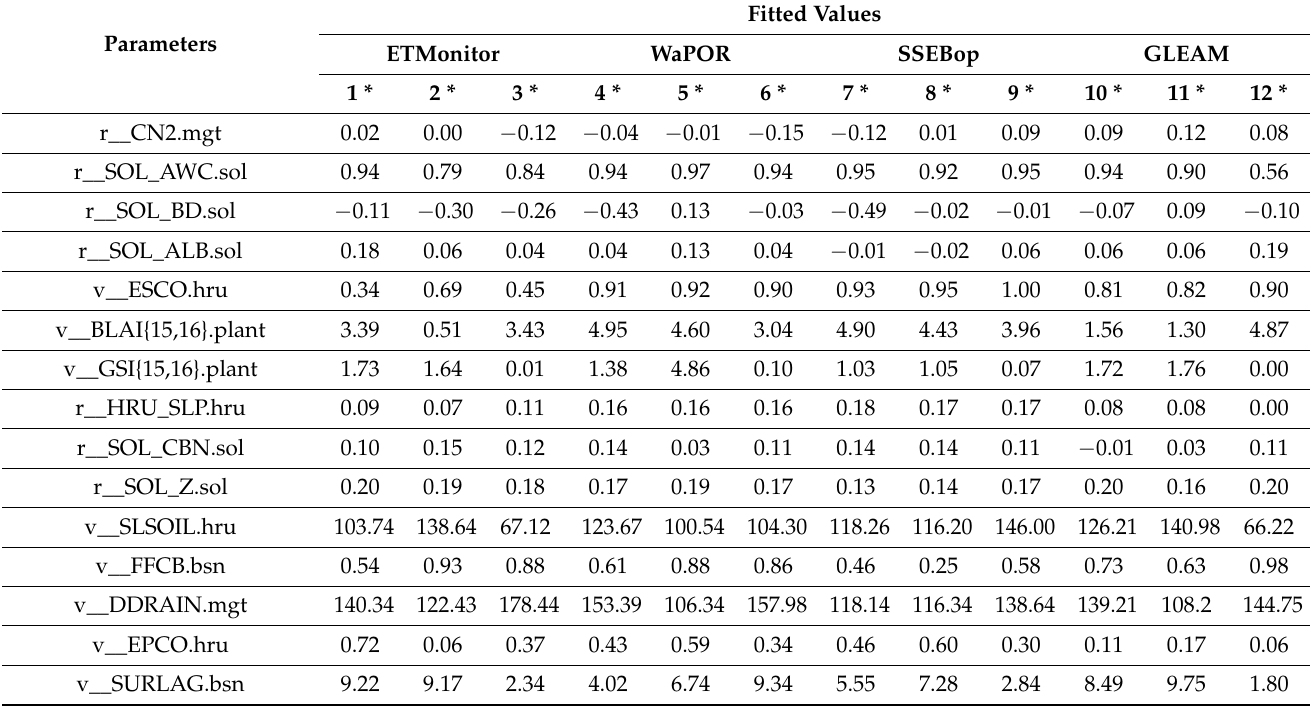
Table A1. The 15 parameters with fitted values for the 12 calibration